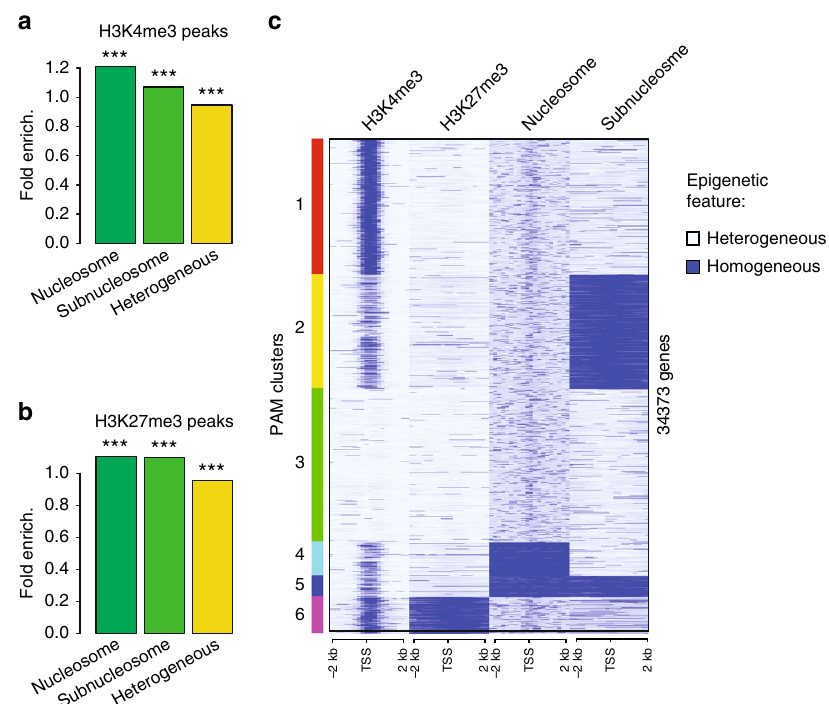
Fig. 4 Homogeneous bivalent marking of histone H3 on sperm developmental genes. a Fold enrichment (observed/random) over 1000 randomisations of peaks with homogeneous H3K4 methylation (HMD > 80) in regions homogeneous for nucleosomes, homogeneous for subnucleosomes or with heterogeneous particle composition in a sperm population; ***: empirical p value < 1e − 3. b Same as in a for H3K27 methylation. c PAM clustering of promoter (TSS + / − 2 kb) according to homogeneity for methylation of histone H3 (HMD > 80) on Lysine 4, on Lysine 27, enrichment for nucleosomes and enrichment for subnucleosomes. Source data related to c is provided as a Source Data fi le. ICe-ChIP data from two independent replicates were